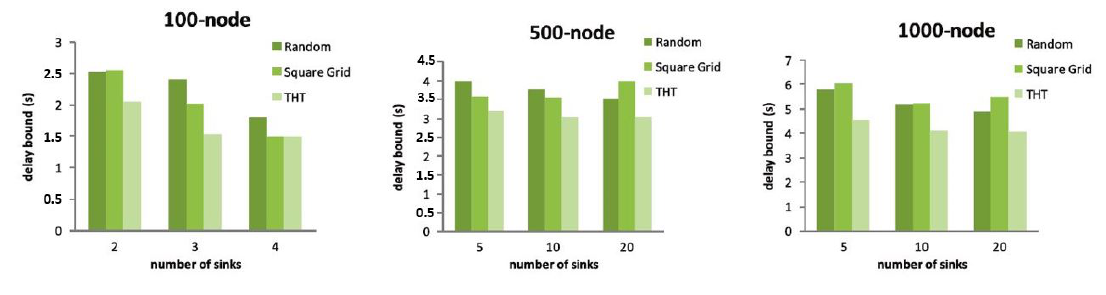
Figure 14. Worst-case delay comparison of three-node placement strategies in different